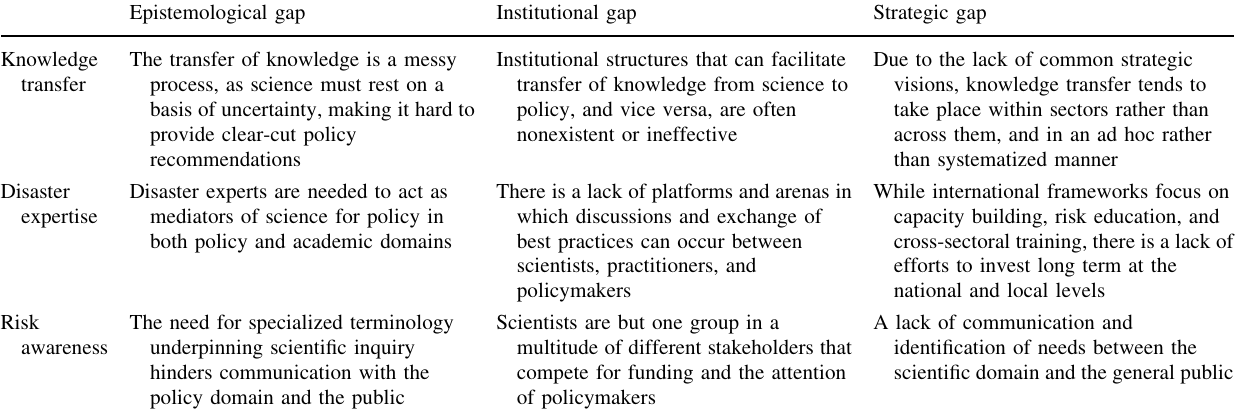
Table 1 Analysis of the three issues and three gaps with respect to the science-policy interface for disaster risk reduction in